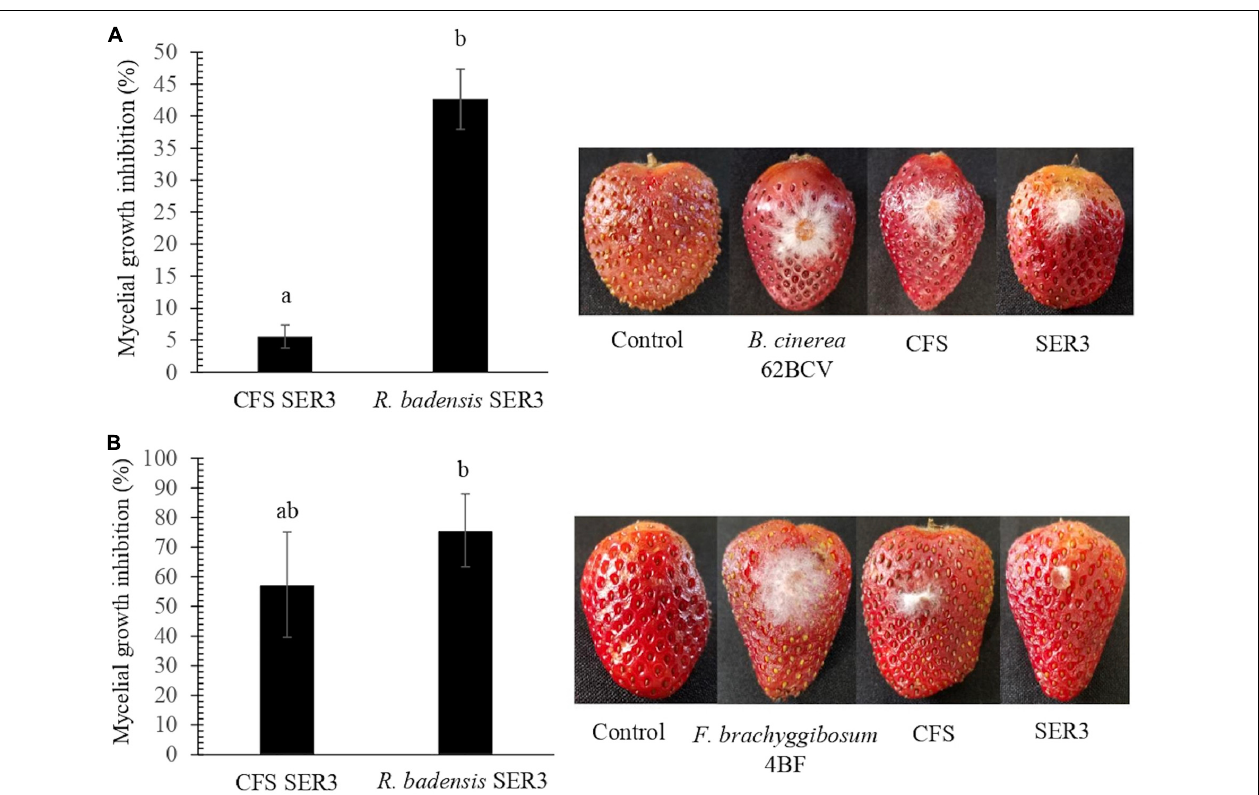
FIGURE 4 | Biocontrol effects of SER3 and its supernatant on strawberries. (A) Mycelial growth inhibition of Botrytis cinerea by the cell-free supernatant (CFS) and SER3. (B) Mycelial growth inhibition of Fusarium brachyggibosum by the CFS and SER3. Treatments consisted of sterile distilled water (control) and inoculation with pathogens, CFS from SER3, and cell suspensions of SER3. Experiments were independently performed three times, and bars represent mean ± SE ( n = 9). Letters indicate significant difference, based on Duncan’s multiple range test ( p < 0.05).